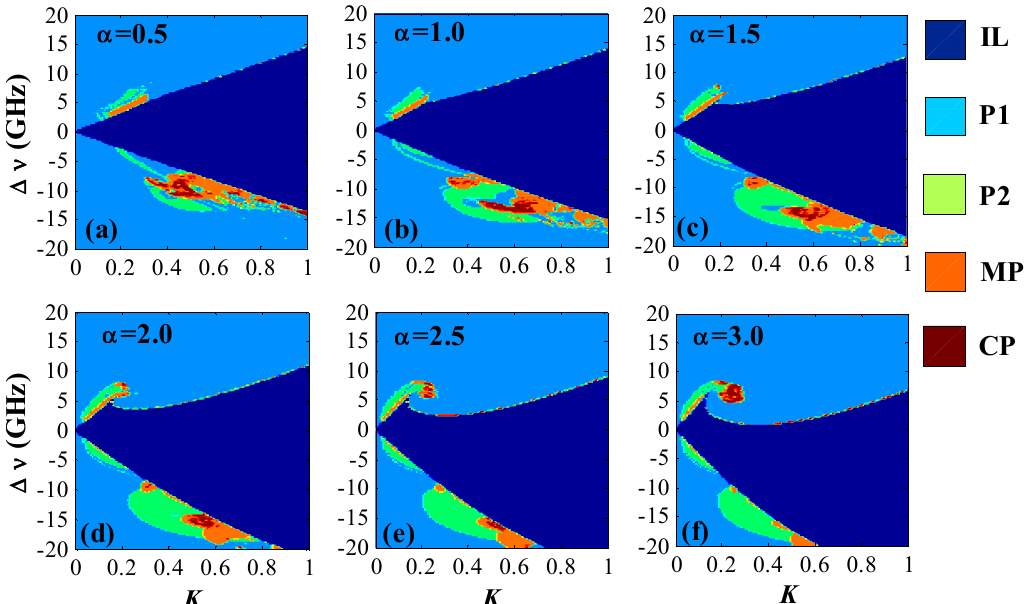
Figure 6. Mappings of the nonlinear dynamics distribution of the ES-QD Laser in the parameter space of injection strength and frequency detuning for different LEF, where ( a ) α = 0.5, ( b ) α = 1.0, ( c ) α = 1.5, ( d ) α = 2.0, ( e ) α = 2.5, and ( f ) α = 3.0. IL: injection locking, P1: period one, P2: period two, MP: multi-period, CP: chaotic pulsation.